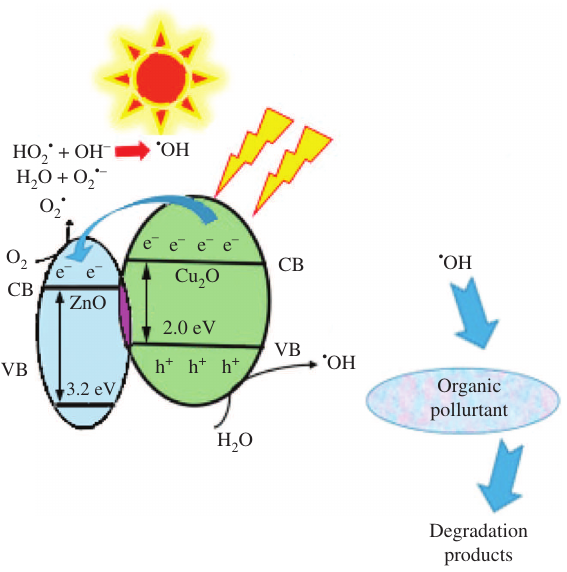
Figure 13: Diagram of the absorption band edge of ZnO and Cu 2 O and the charge transfer under visible light irradiation.